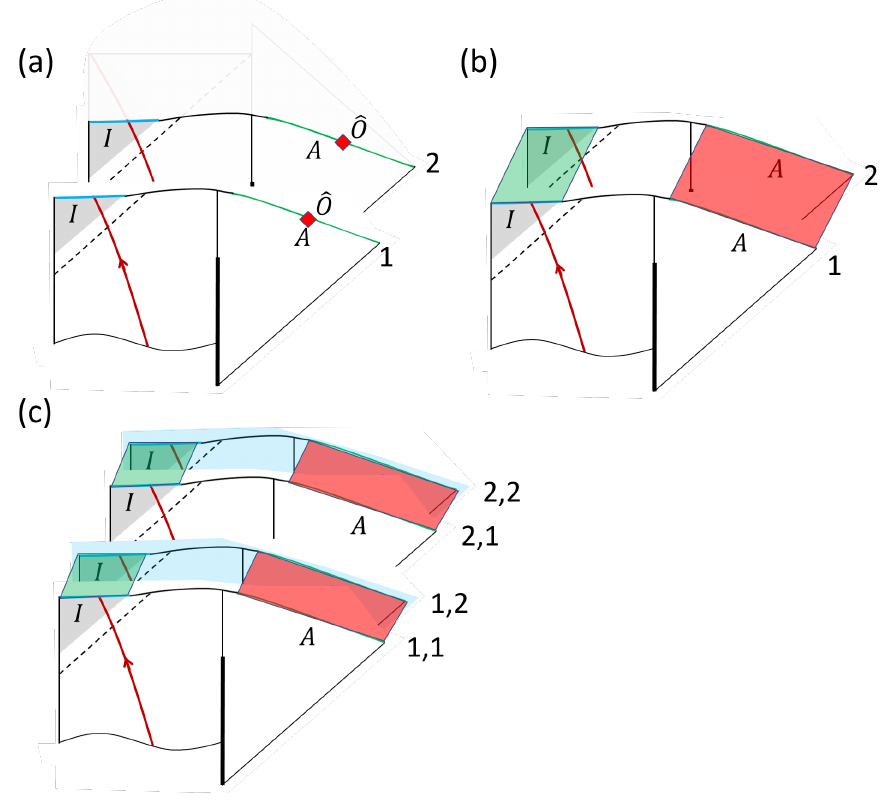
Figure 5 . Illustration of the replica calculation for (a) tr( ρ A ˆ O ) n for a regular operator ˆ O , (b) tr ( ρ n (cid:16) (cid:17) n and (c) tr ρ A Z ( k ) with Z ( k ) defined in eq. (4.3). The illustration shows the case n = 2 , k = 1 A A